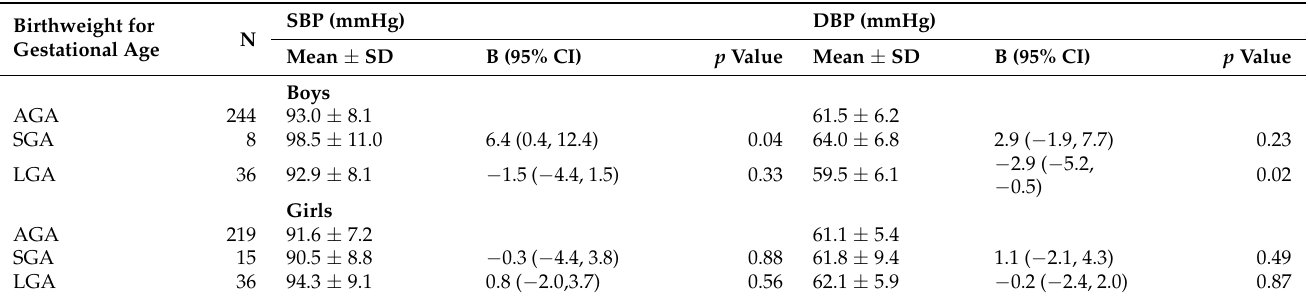
Table 4. The associations between birthweight for gestational age status (LGA, AGA, and SGA) and blood pressure in children at age 2